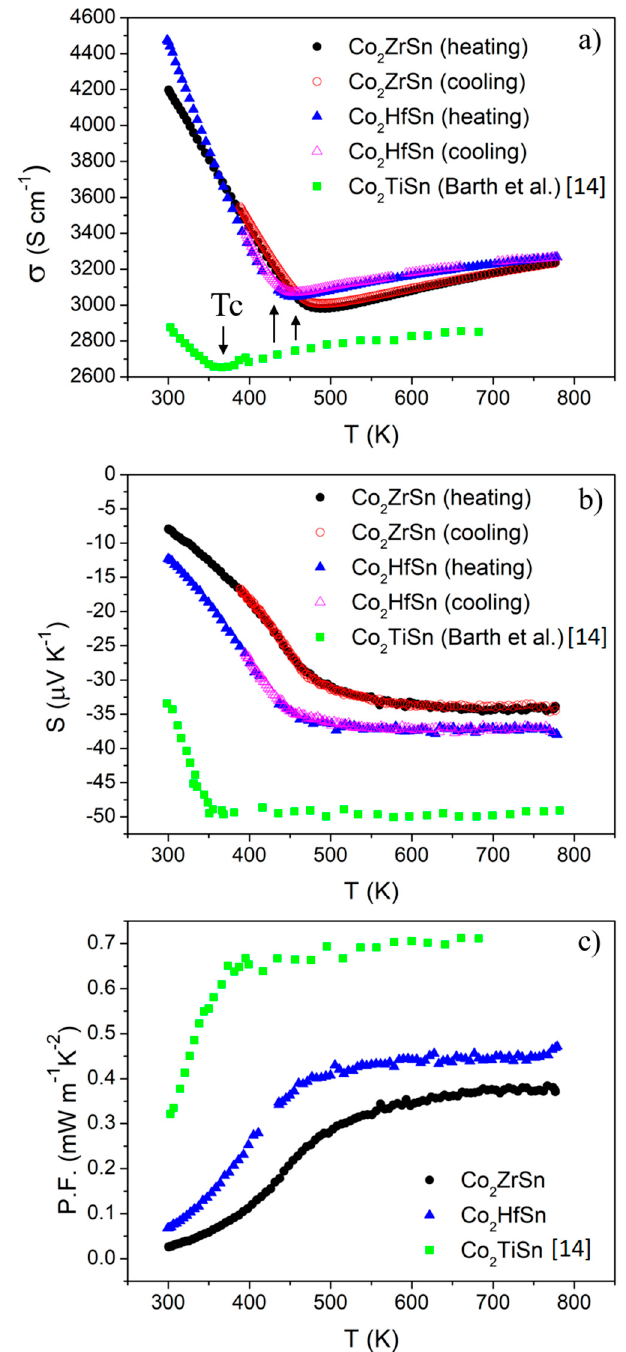
Figure 4. Electrical conductivity ( a ), Seebeck coefficient ( b ), and power factor ( c ) of the Co 2 ZrSn and Co 2 HfSn alloys. The transport properties of Co 2 TiSn are shown as a comparison [14].